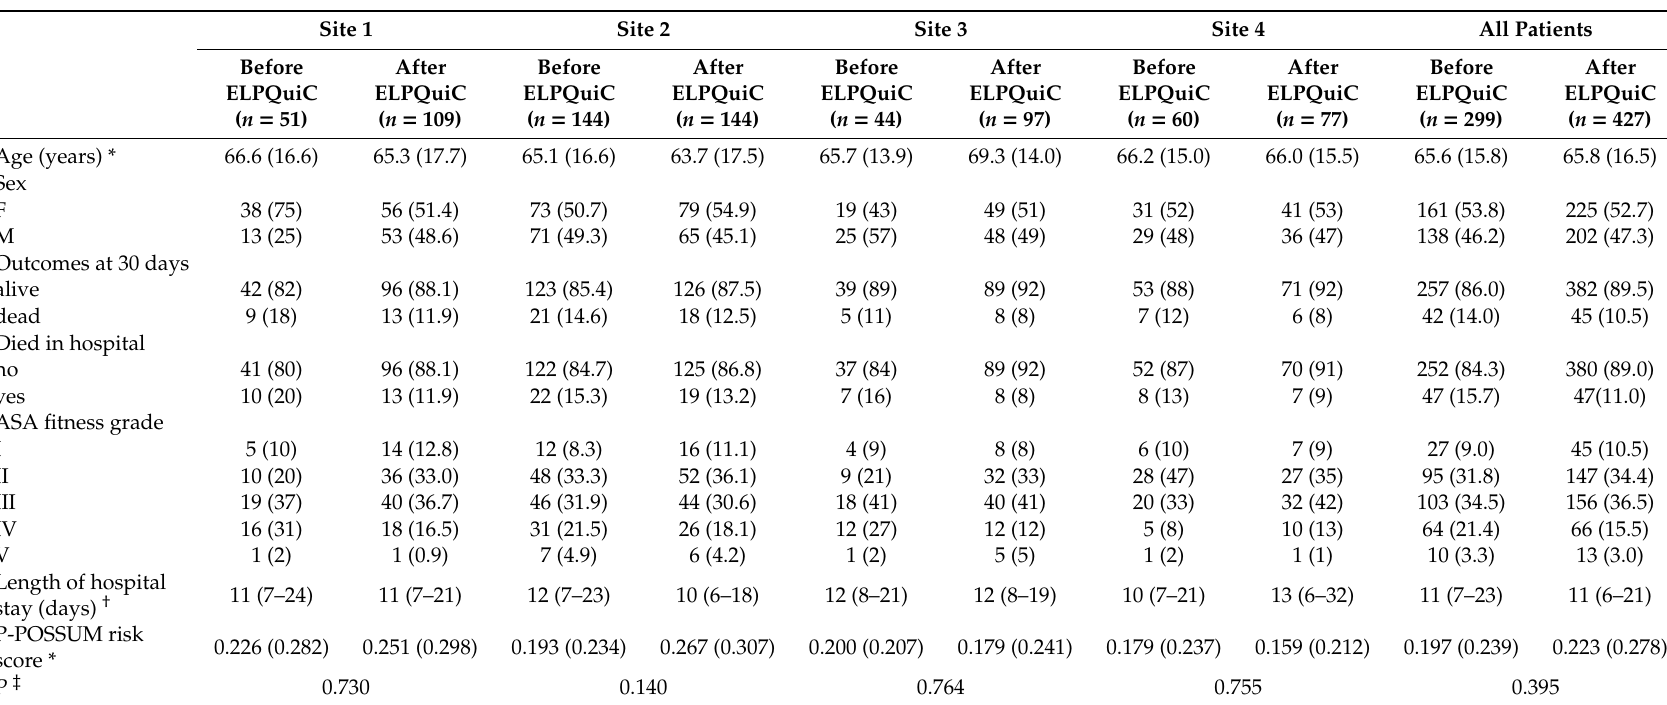
Table 1. Demographics and outcomes of patients before and after inplementation of the emergency laparotomy pathway quality improvement care bundle.